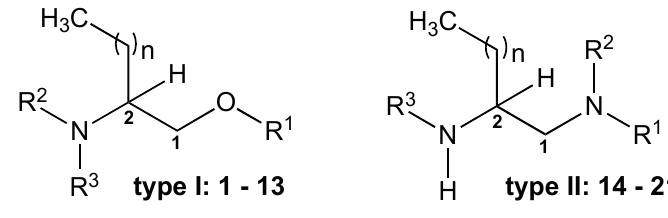
Figure 1. General structure of compounds type I and